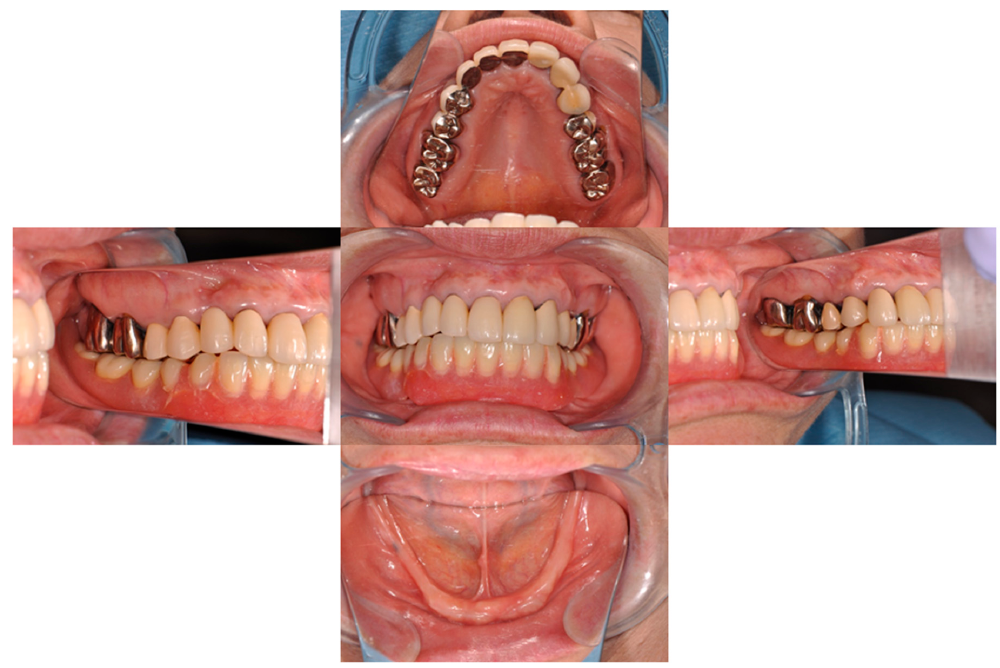
Figure 1. Preoperative view of oral cavity.